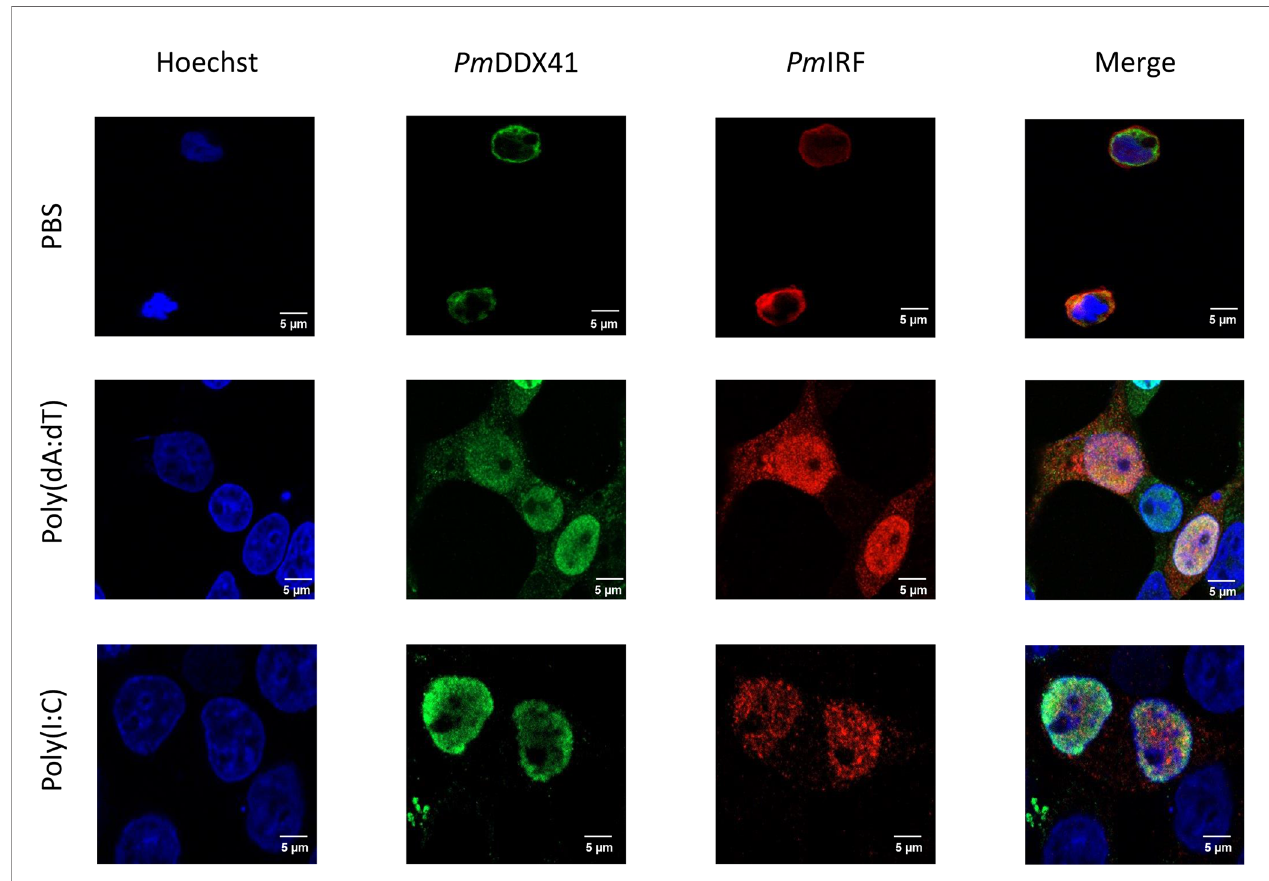
FIGURE 6 | Subcellular localization of Pm IRF and Pm DDX41 in HEK293T cells. Cells were co-transfected with Myc-tagged Pm DDX41 and Flag-tagged Pm IRF expression plasmids for 24 h, then stimulated with 1 m g/ml poly((dA:dT) or HMW poly(I:C) for 6 h before labeling with an Alexa Fluor 568-conjugated anti-Flag antibody (red) and Alexa Fluor 488-conjugated anti-Myc antibody (green). Nuclei were stained with Hoechst 33342 (blue). Scale bar, 5 m m. Fluorescence was detected by laser scanning confocal microscopy (63× magni fi